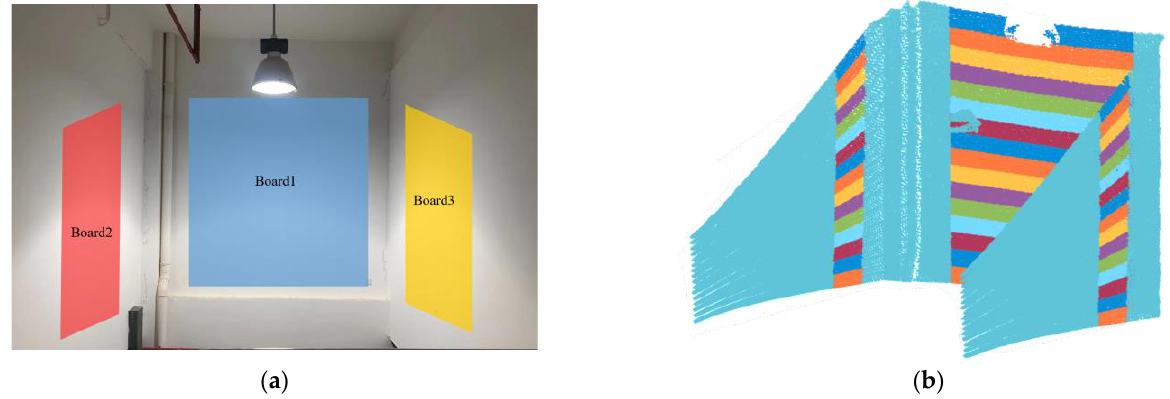
Figure 9. U-shape Experiment wall scene: ( a ) Experimental scene. ( b ) Point clouds for calibration. Table 2. Parameter Calibration Results ( k = 0.2 in Equation